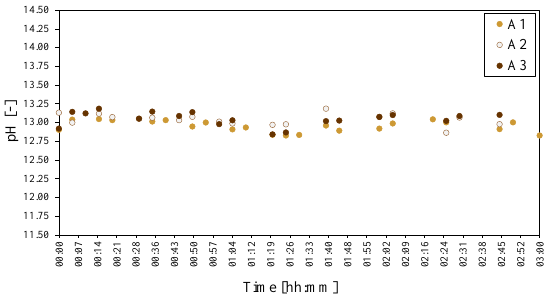
Figure 18. pHs of the morphology/crystallinity of Al(OH) 3 series of LDHs A1 = SA, A2 = ACE and A3 = M. The pH was adjusted to 25 ◦ C to facilitate